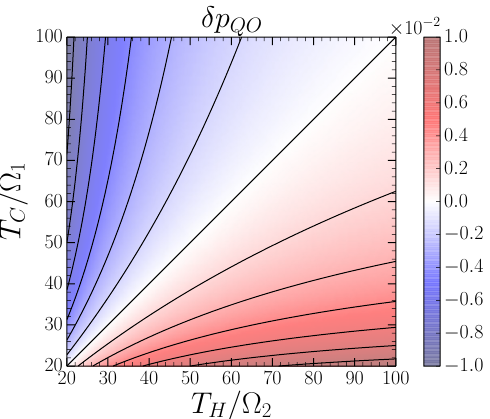
Figure 2. The population change for the original quantum Otto cycle. Red regions show positive corrections and blue